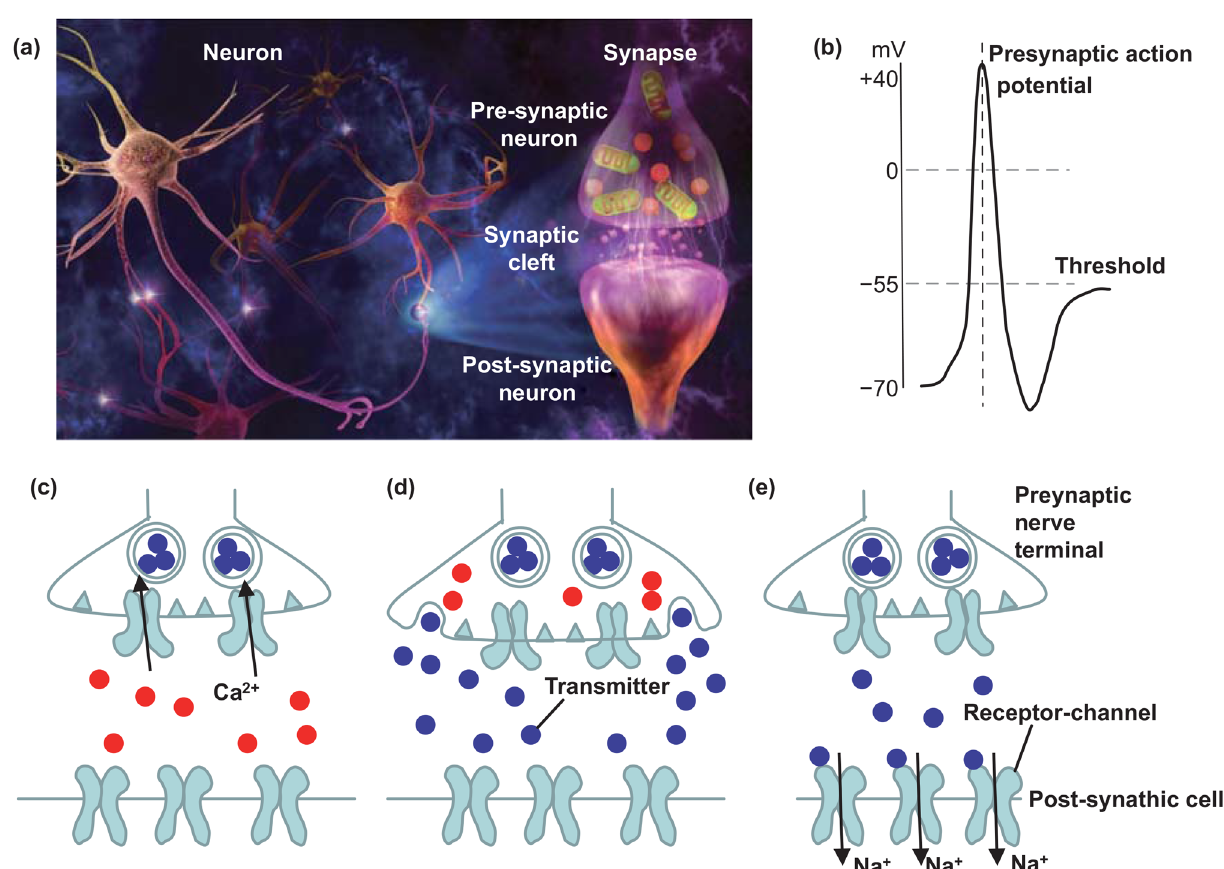
Fig. 1 a Schematic of biological neurons and synapse. Reproduced with permission from Ref. [4]. b Illustration of an action potential arriving at the presynaptic terminal. c Opening of voltage-gated Ca 2+ channels at the active zone in response to the action potential. d Release of neu- rotransmitters in the vesicles into the synaptic cleft. e Diffusion of neurotransmitters across the cleft and binding with specific receptors on the postsynaptic terminal. b – e Adapted with permission from Ref.